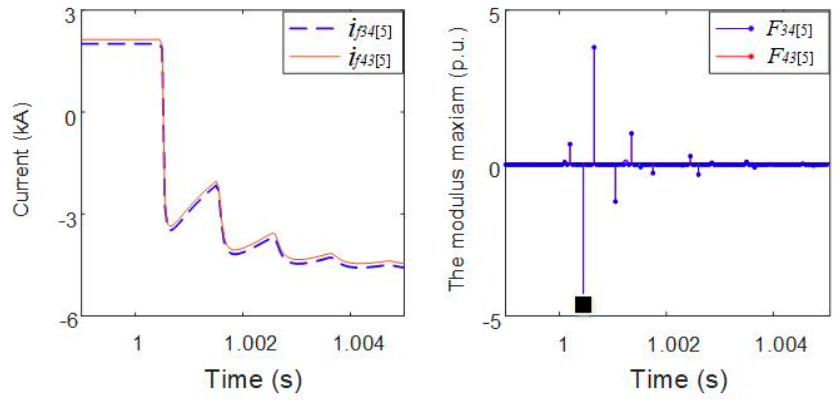
Figure 11. Simulation results of fifth mode FTWC when a pole to ground (PG) fault at L 34 .